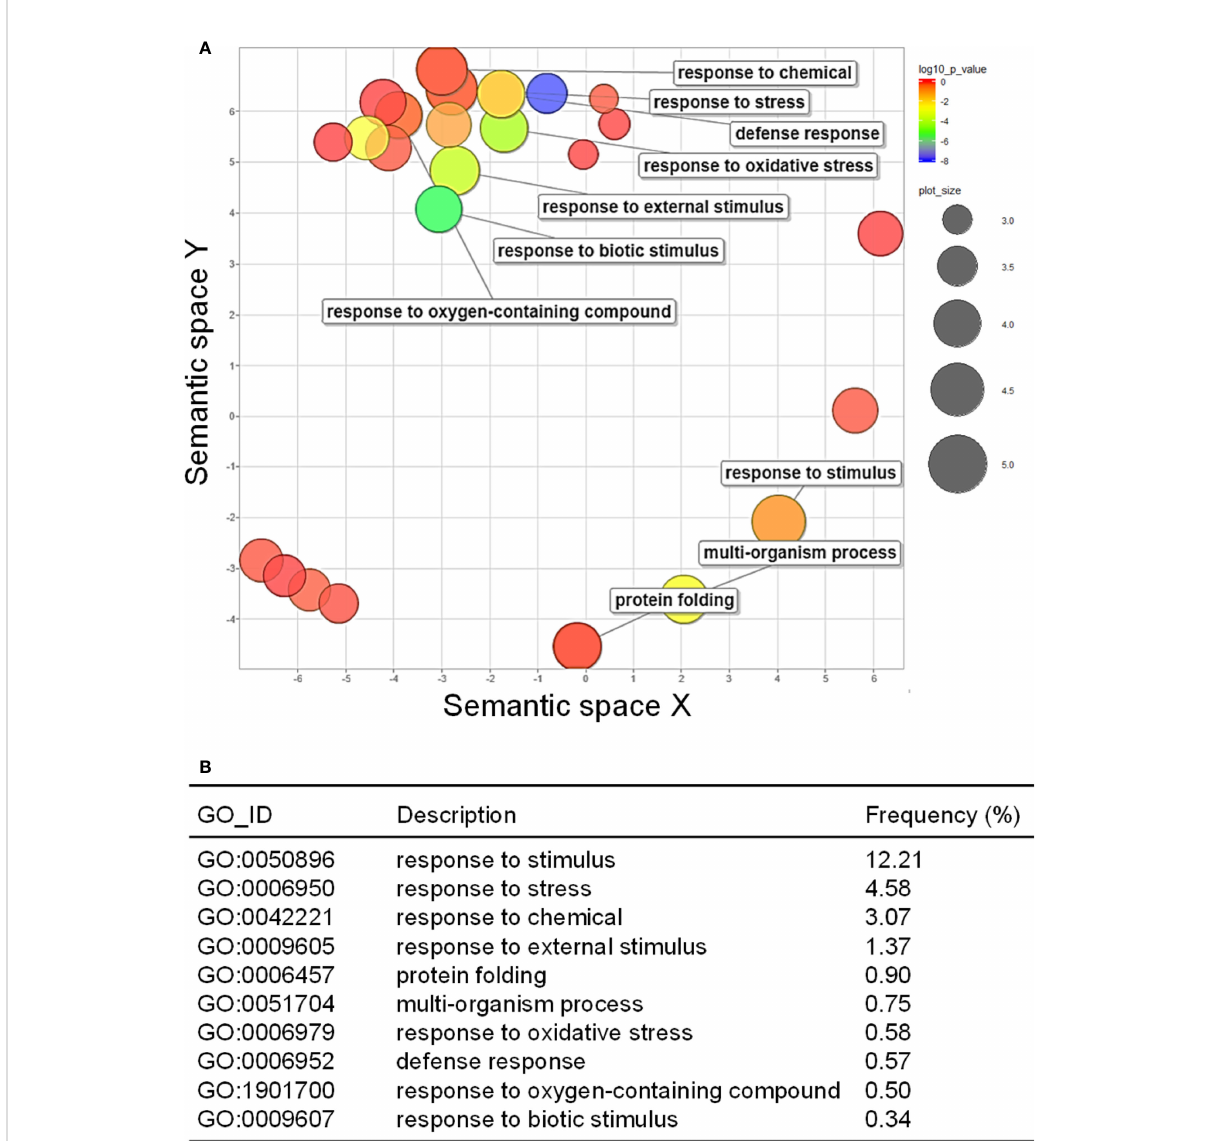
FIGURE 4 GO enrichment of upregulated DEGs. (A) GO enrichment in the biological process category, as visualized using REVIGO. The scatter plot shows the signi fi cance of GO terms in a two-dimensional space. Multi-dimensional scaling was applied to a matrix of GO terms to calculate semantic similarities. Colors indicate the P -value for the false discovery rate, and circle sizes represent the frequency of the GO term. (B) Top 10 GO terms enriched for the upregulated DEGs in response to CMV infection.